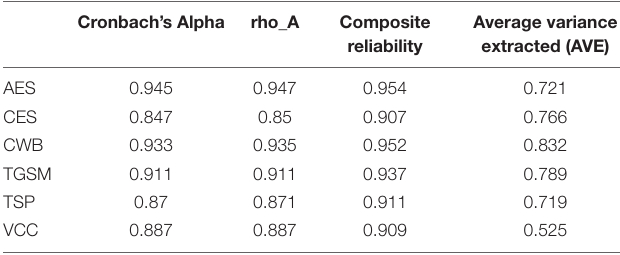
TABLE 2 | Convergent validity and